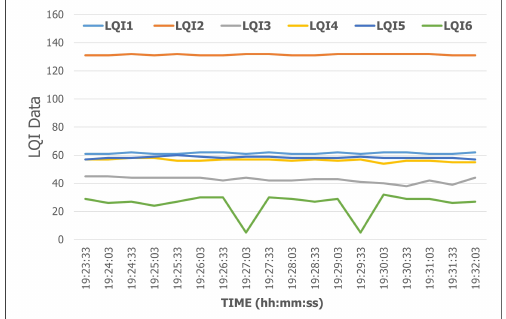
Figure 18. LQI data of transmitter 1